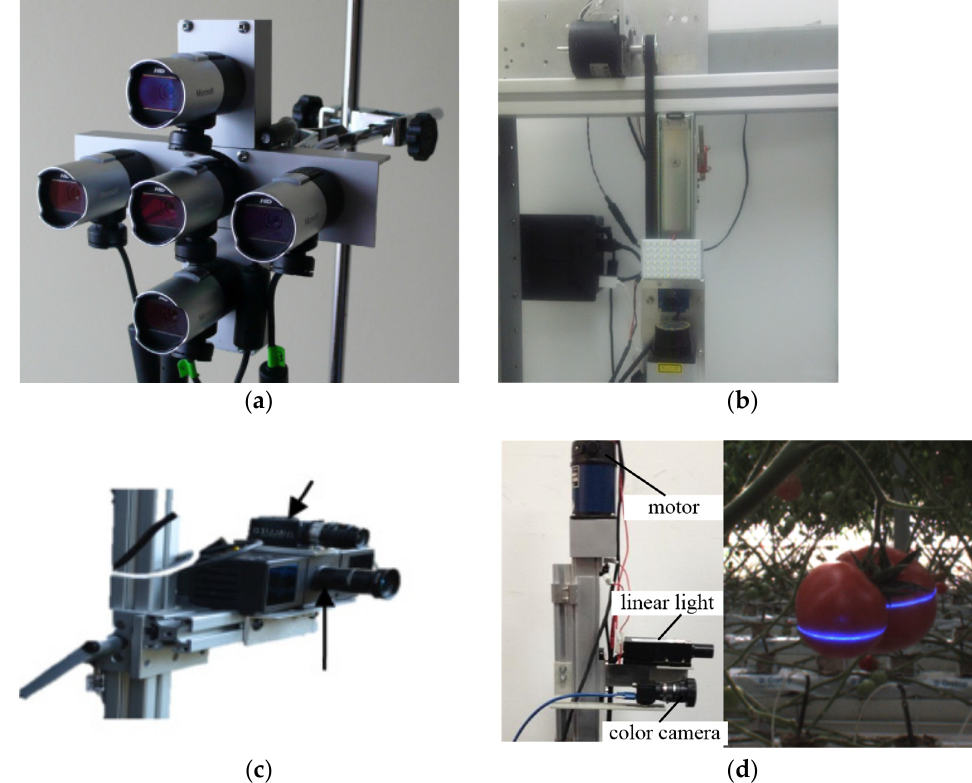
Figure 9. Stereo vision system for fruit harvesting. ( a ) Multiple cameras set for obtaining depth maps of plants (Photo: Reprinted with permission from Ref. [89]. 2017, Kaczmarek A.L.); ( b ) camera and laser sensor combined application for pepper 3D pose estimation (Photo: Reprinted with permission from Ref. [92]. 2016, Eizentals P.); ( c ) 2D and 3D cameras combined application for apple fruit yield estimation (Photo: Reprinted with permission from Ref. [93]. 2016, Gongal A.); ( d ) structured light stripe vision unit for overlapped tomato fruits (Photo: Reprinted with permission from Ref. [94]. 2014, Feng Q.).